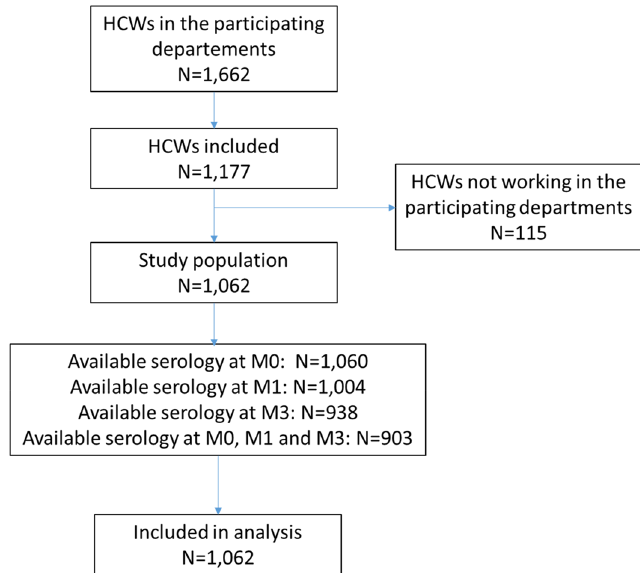
Figure 1. Flow chart. M, month.